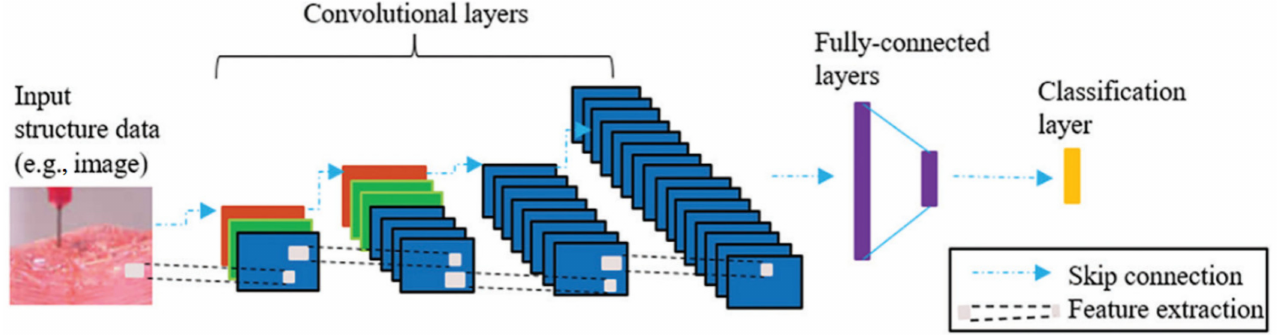
Figure 6. A framework of convolutional neural networks used in bioprinting (adapted from [54] with